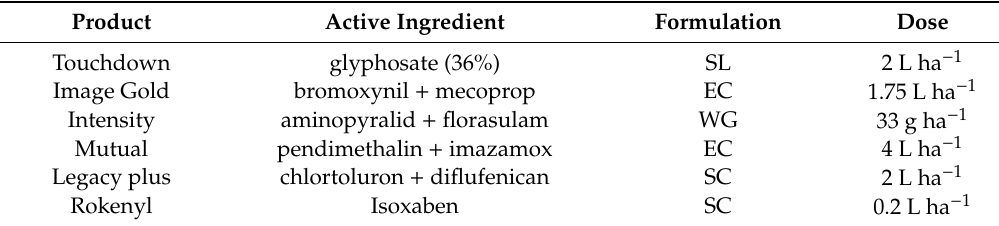
Table 7. Herbicides applied during the three growing seasons. SL soluble concentration; EC, emulsionable concentration; WG, water dispersable granulate; SC, concentrated suspension.